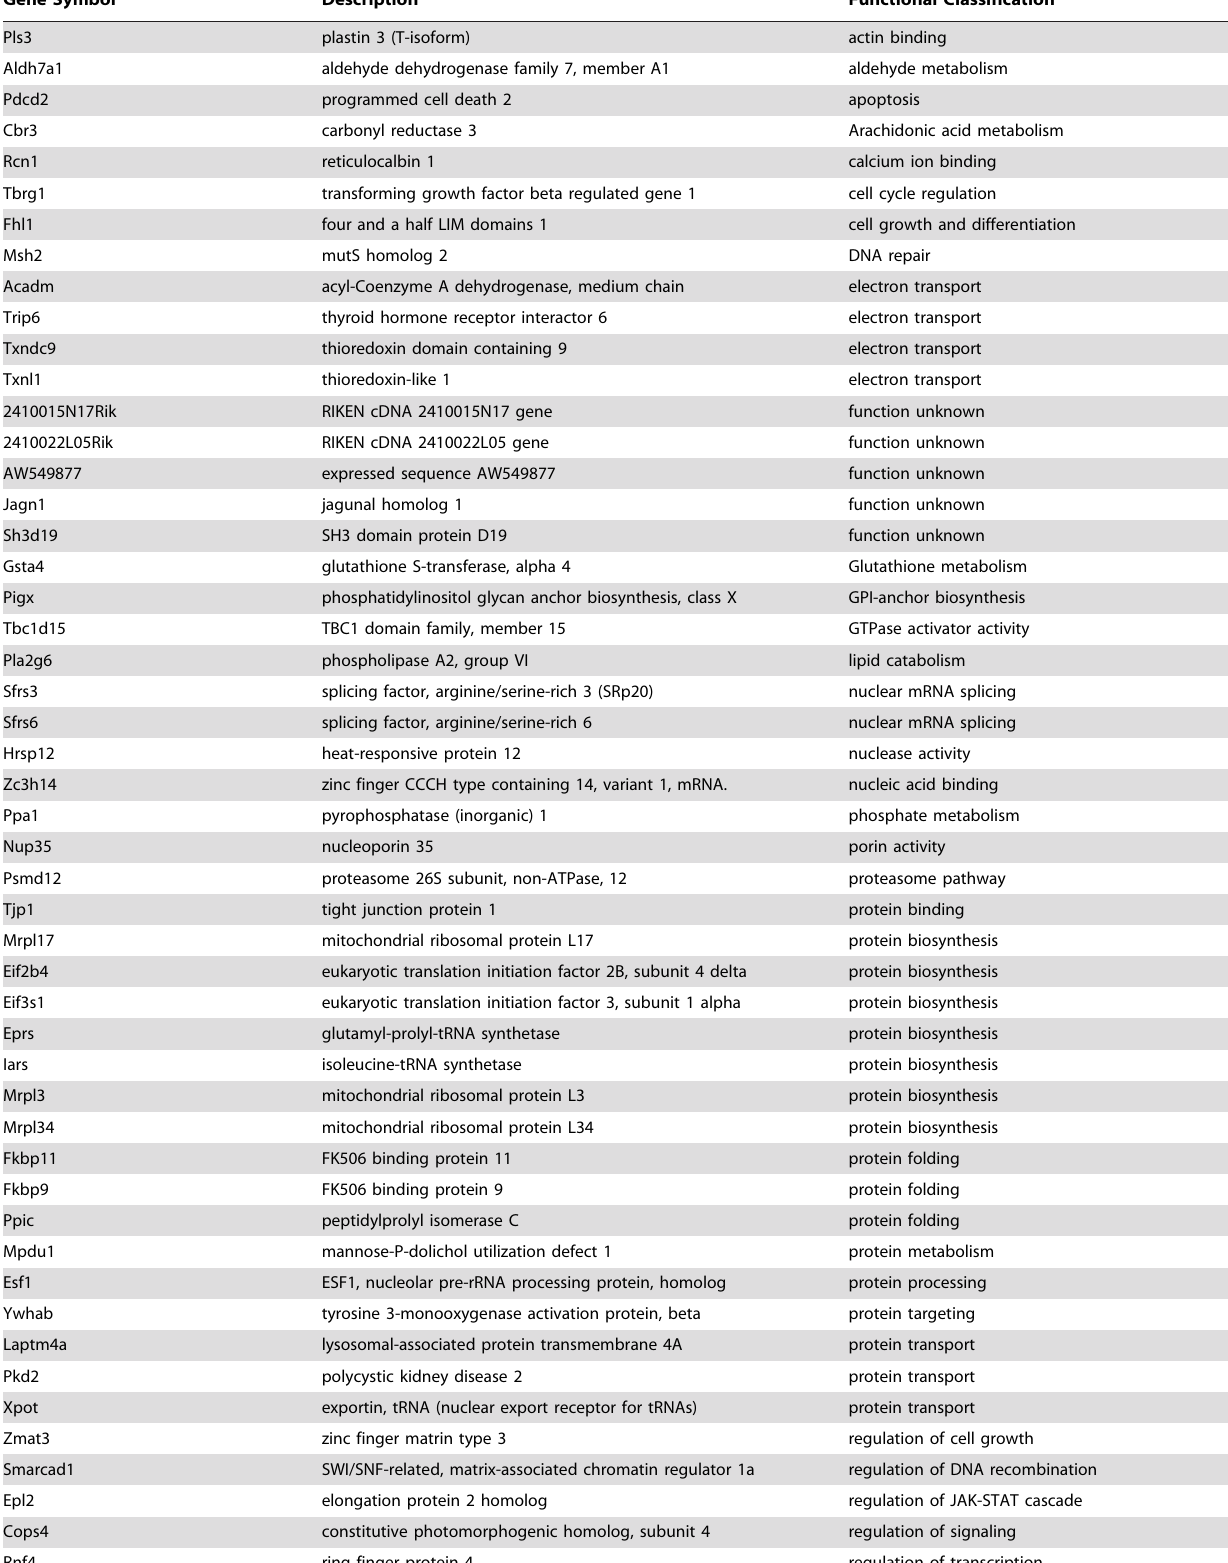
Table 8. Stem cell-enriched genes expressed in Bergmann